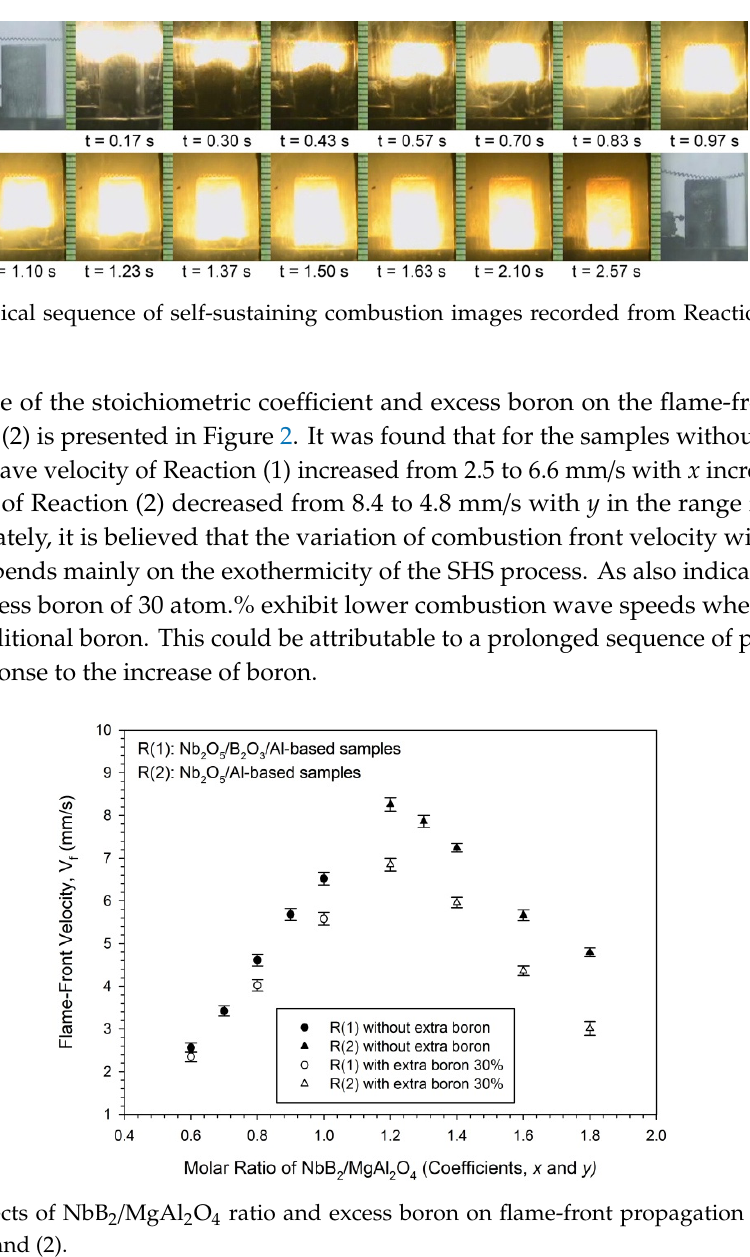
Figure 1. Typical sequence of self-sustaining combustion images recorded from Reaction (2) with y = 1.4.